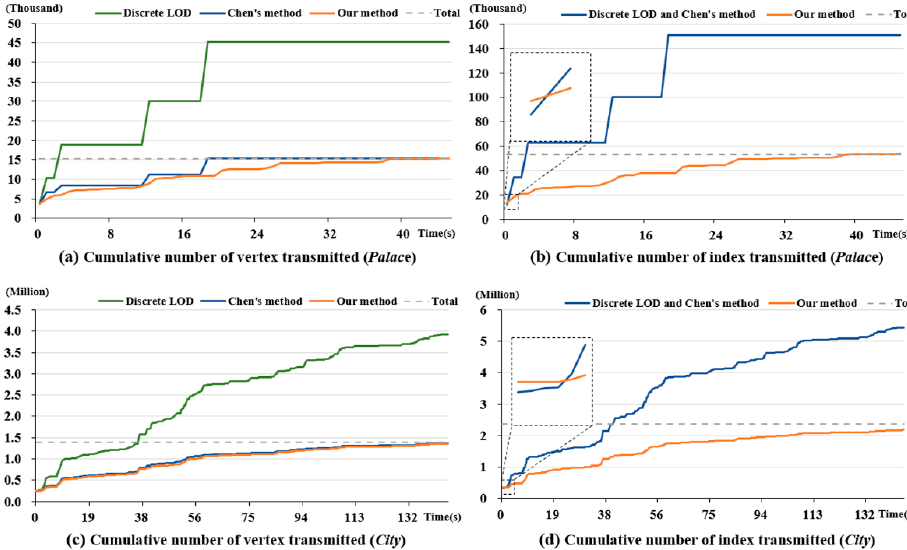
Figure 12. Transmission data statistic: ( a ) Cumulative number of vertices transmitted of Palace; ( b ) cumulative number of index transmitted of Palace; ( c ) cumulative number of vertices transmitted of City; ( d ) cumulative number of index transmitted of City. Table 3. Refinement delay time statistics.